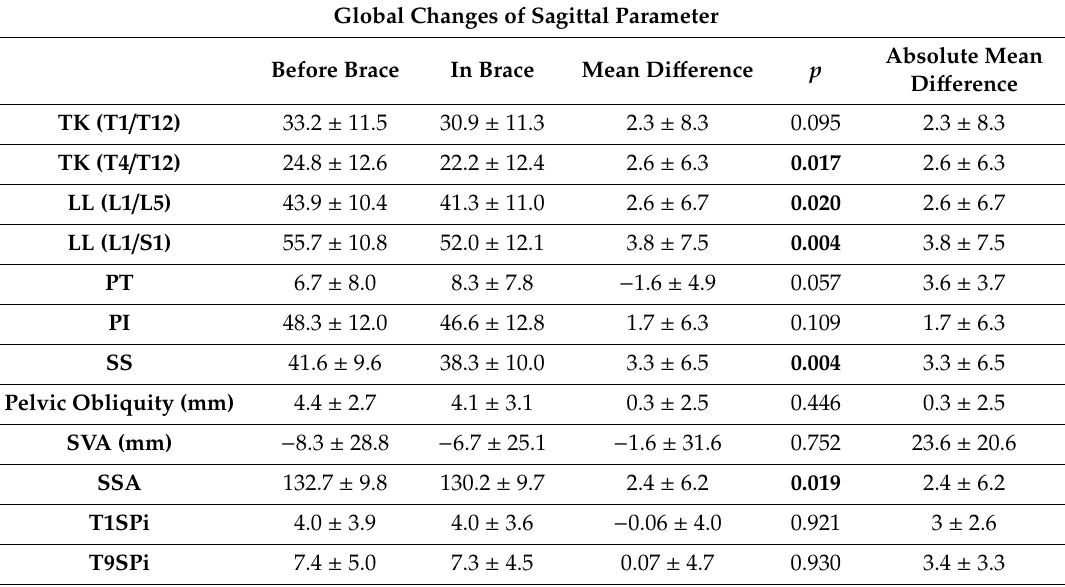
Table 1. Pre- to in-brace changes of sagittal parameters regardless of curve